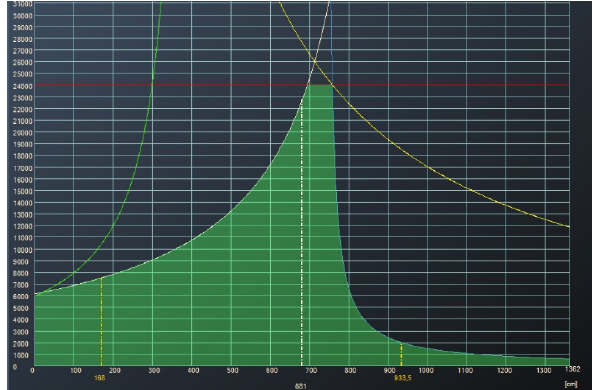
Table 2: The main technical parameters of compared transport units